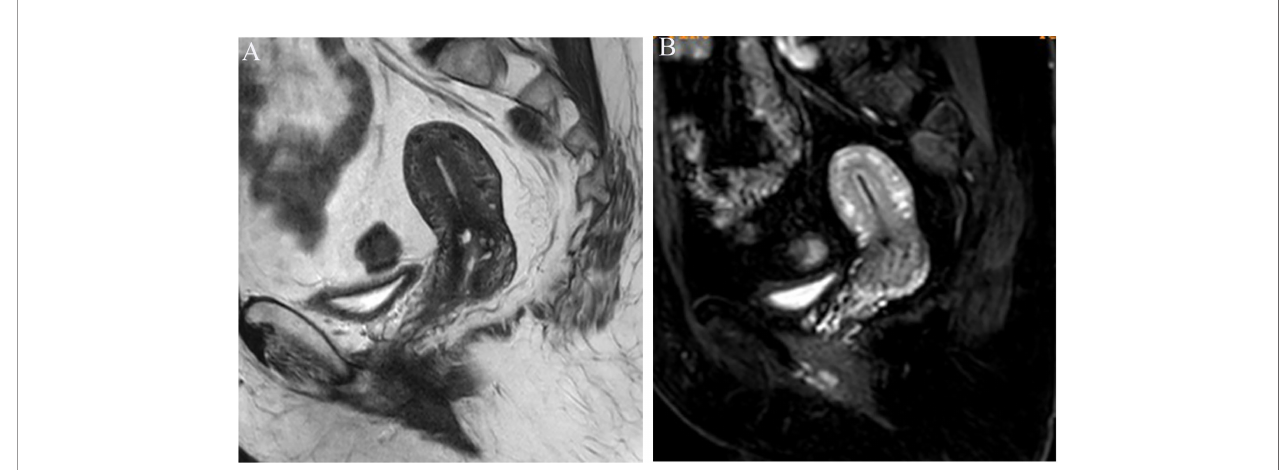
FIGURE 1 | (A) Sagittal-T2WI image, no de fi nitive lesion is found in the uterine cavity. (B) Early (25.1 s) sagittal-DCE image shows the SEE, a thin enhancement layer between the endometrium and myometrium that is regular and smooth. This case was histologically proven to have endometrioid carcinoma, G1 with no myometrial